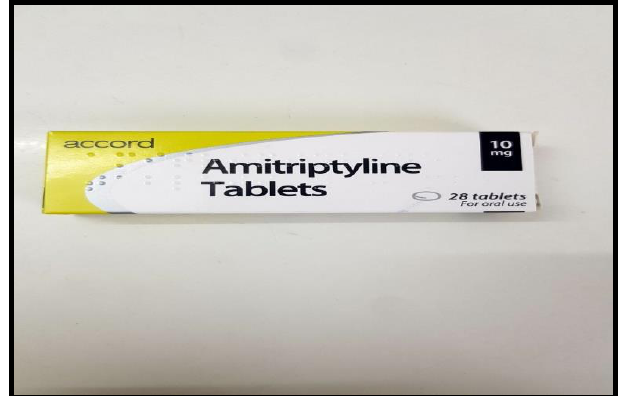
Fig.1: Amitriptyline tablet used in this study